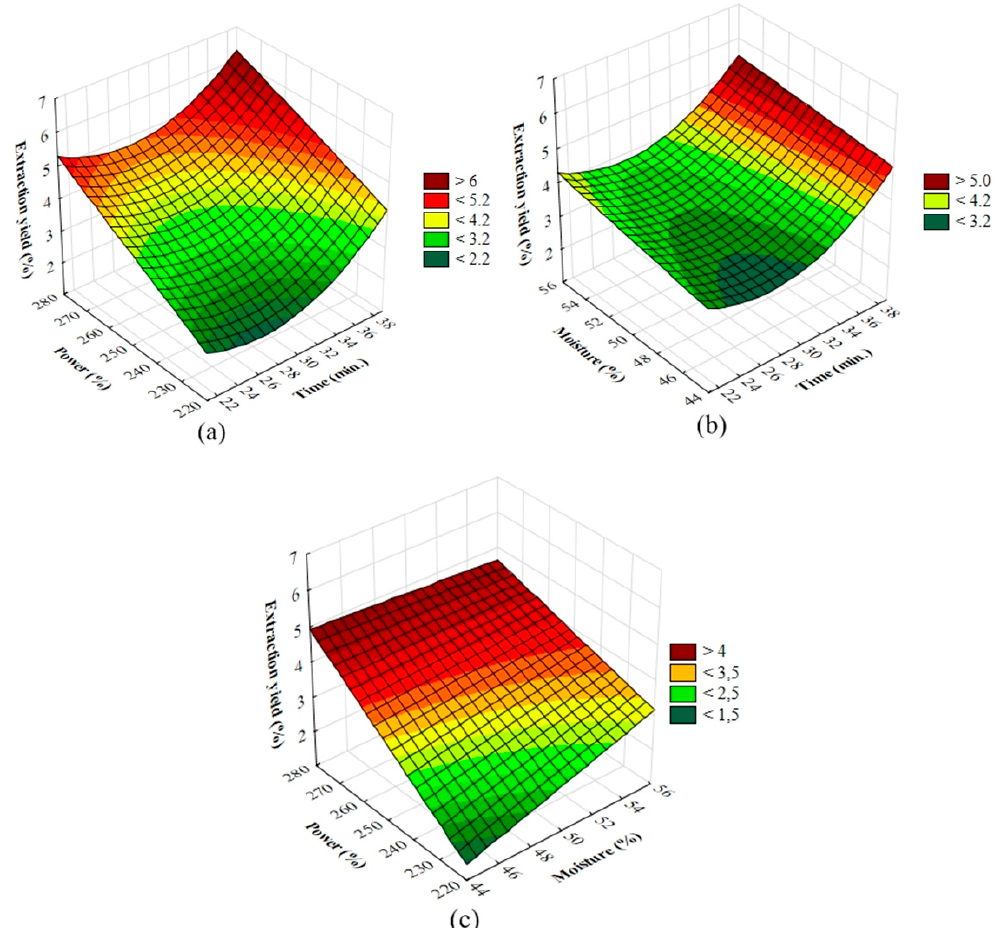
Figure 1. Response surface plots show the effect of time (min), moisture (%) and microwave power (W) on the extraction yield (%) ( a ) the yield values increased as time and power increased; ( b